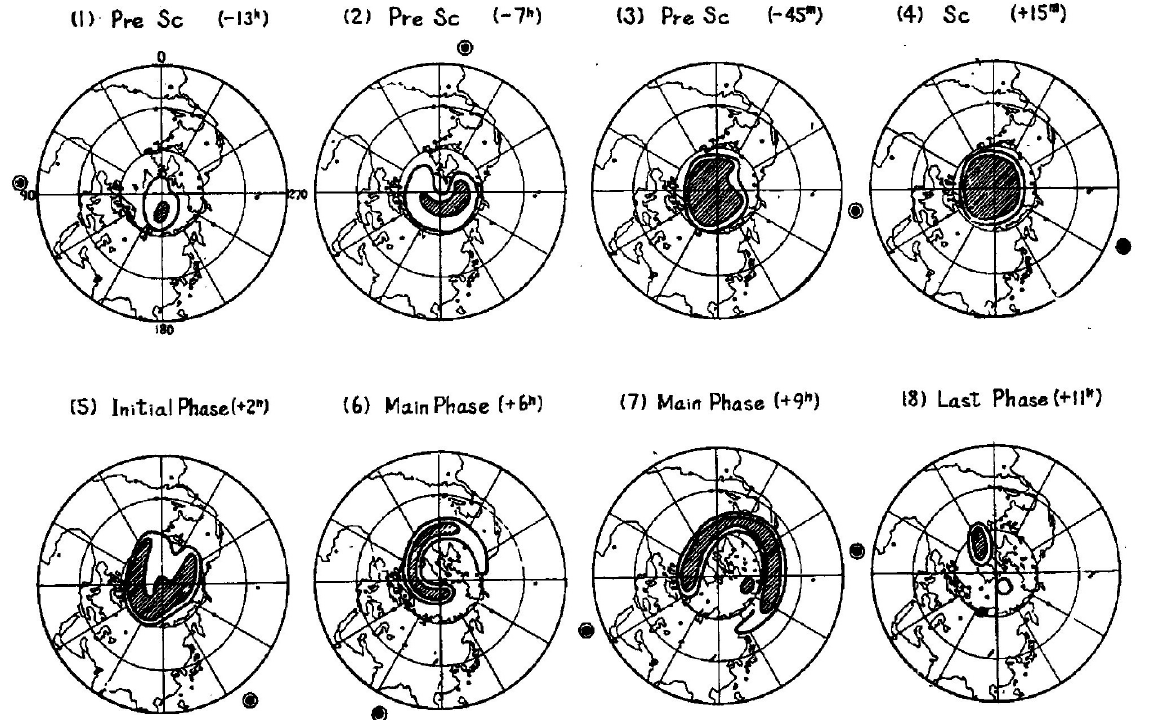
Figure 13. Sequence of the ionospheric absorption following a solar radio burst. Times in the parenthesis are counted from the geomagnetic storm sudden commencement. (2) Absorption begins several hours before the storm onset, (3) fills the polar cap, and (5 to 8) moves to the auroral zone after the onset (Obayashi and Hakura, 1960a).